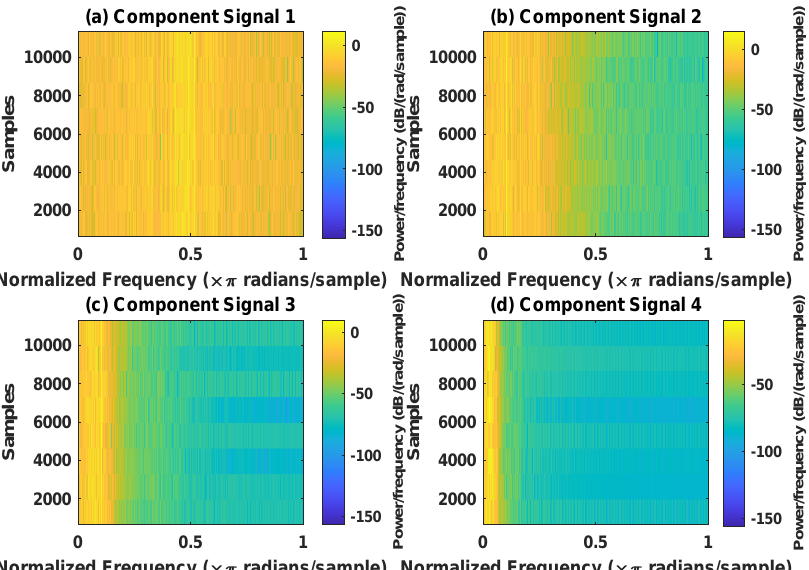
Figure 21. Decomposition results of EMD with m = 16: ( a – d ) time–frequency diagram of 1st to 4th subcomponents,